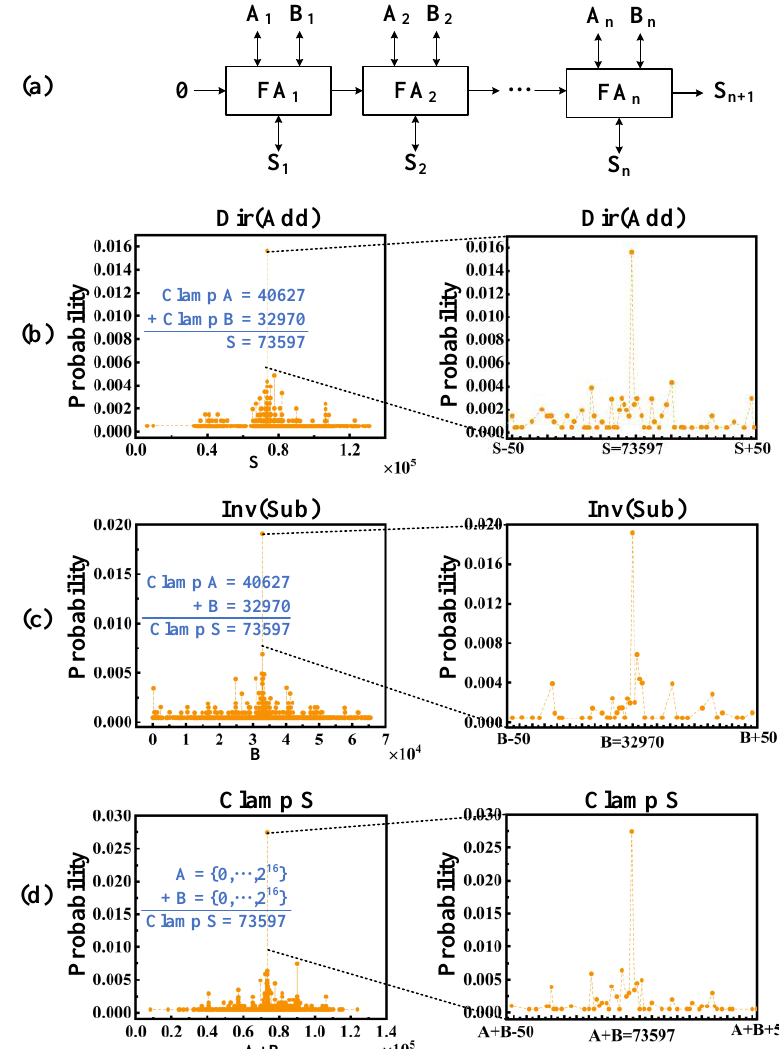
Figure 8. Invertible 16-bit RAC operation. ( a ) N-bit RCA is designed based on constructed invertible full adders; ( b ) clamping A and B working in directional mode (used for addition). The left is the statistics of S over a period, and the right is the statistics of 100 samples around the correct S; ( c ) clamping A and S working in inverse mode (used for subtraction); ( d ) only clamping S, and the statistics of A + B.